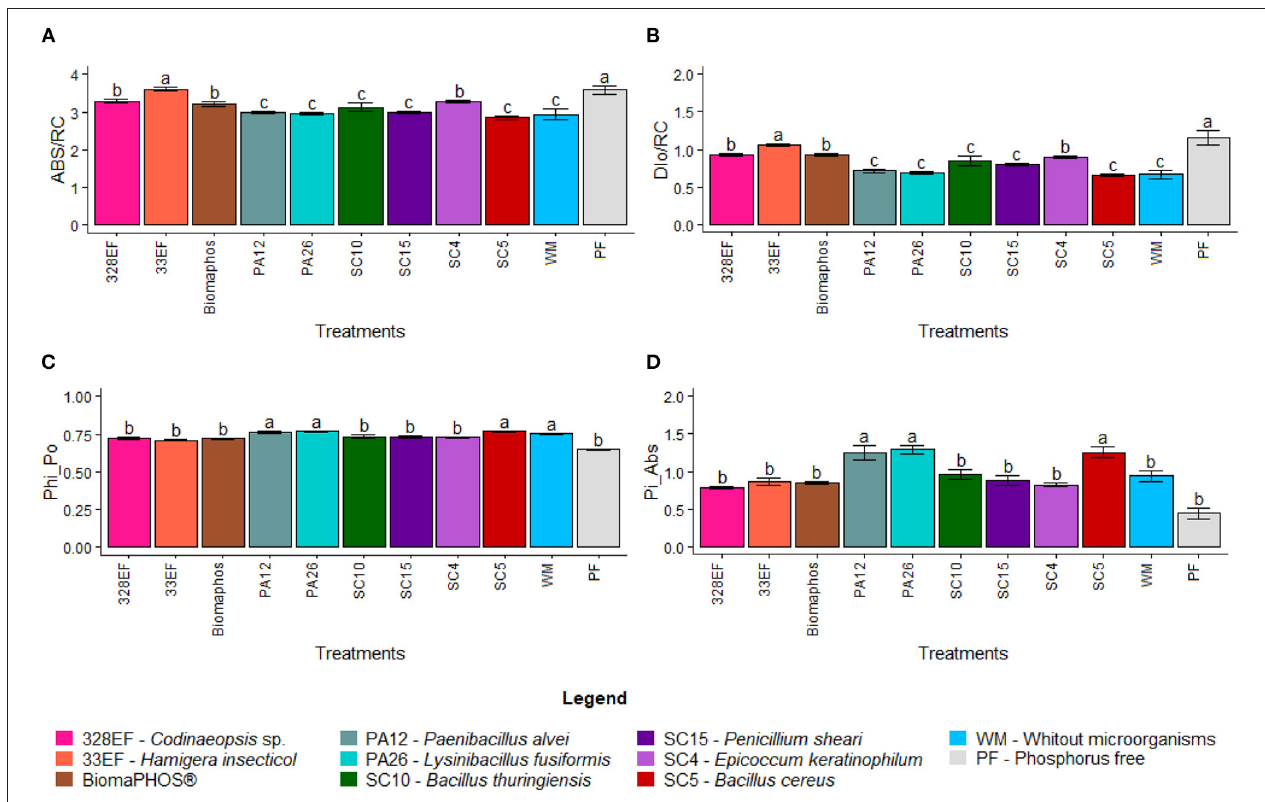
FIGURE 5 | Absorption flow by RC (ABS/RC) (A) , specific energy dissipation flow (DIo/RC) (B) , the maximum quantum yield of primary photochemistry (PHI_Po) (C) , and photosynthetic performance index (Pi_Abs) (D) in soybean plants ( G. max) grown in nutrient solution providing calcium phosphate (CaHPO 4 ) as a phosphate source and inoculated with four bacterial strains and four fungal strains. Means followed by the same letter do not differ from one another according to the Scott-Knott test at 5% probability.